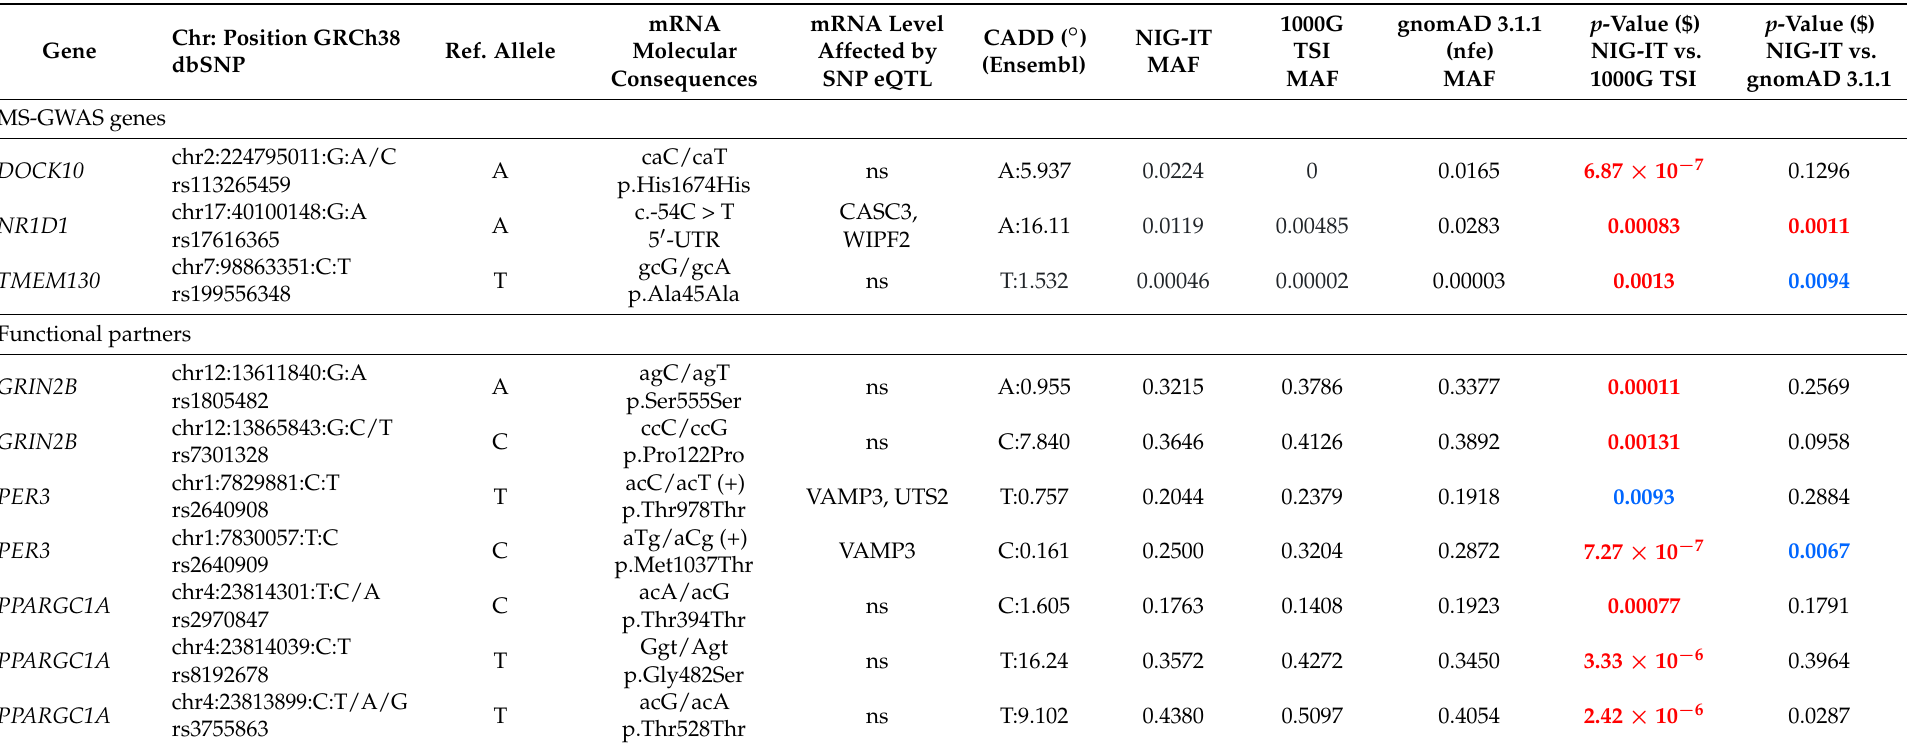
Table 3. Nonintronic variants with significant differences in allele frequency between affected and control Italian